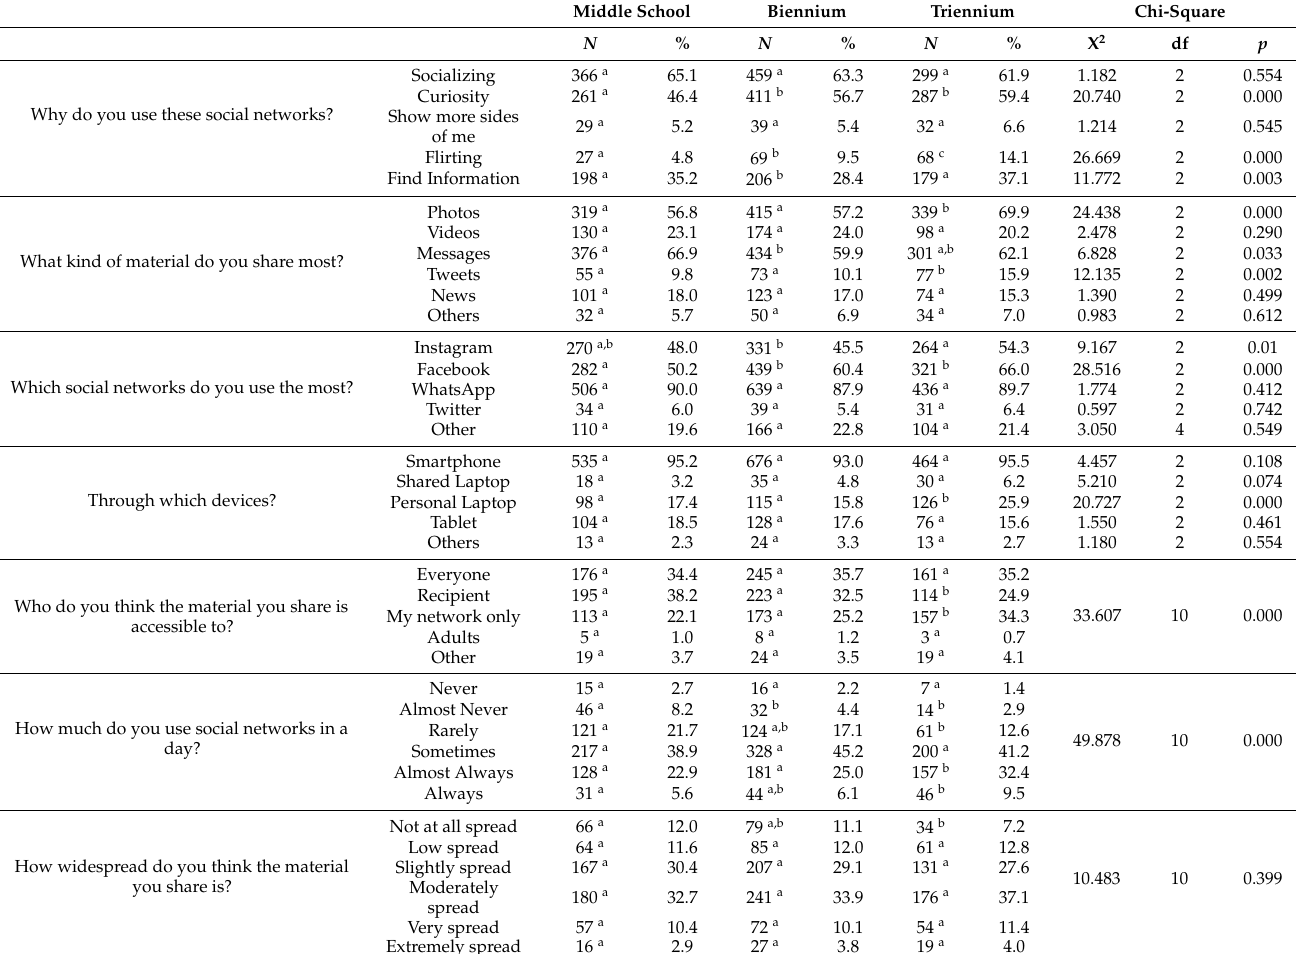
Table 2. Frequency Analysis of use of the Internet in student